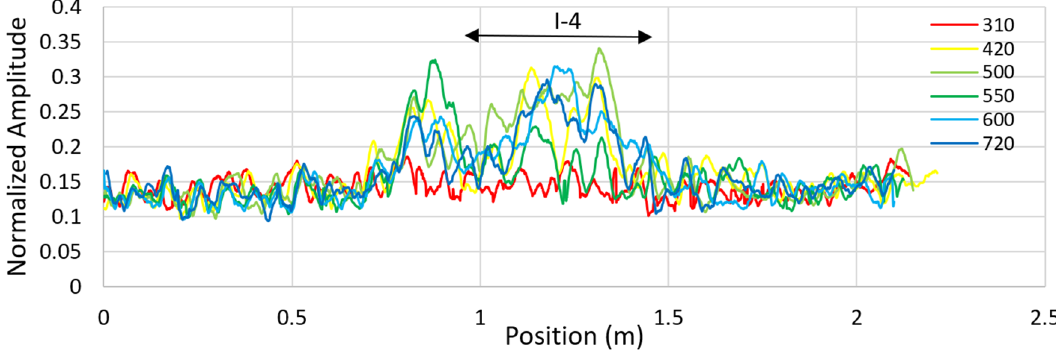
Remote Sens. 2021 , 13 , x FOR PEER REVIEW Figure 29. 2.6 GHz Normalized RW amplitudes on defect I-4, in the longitudinal direction vs. K loadings.